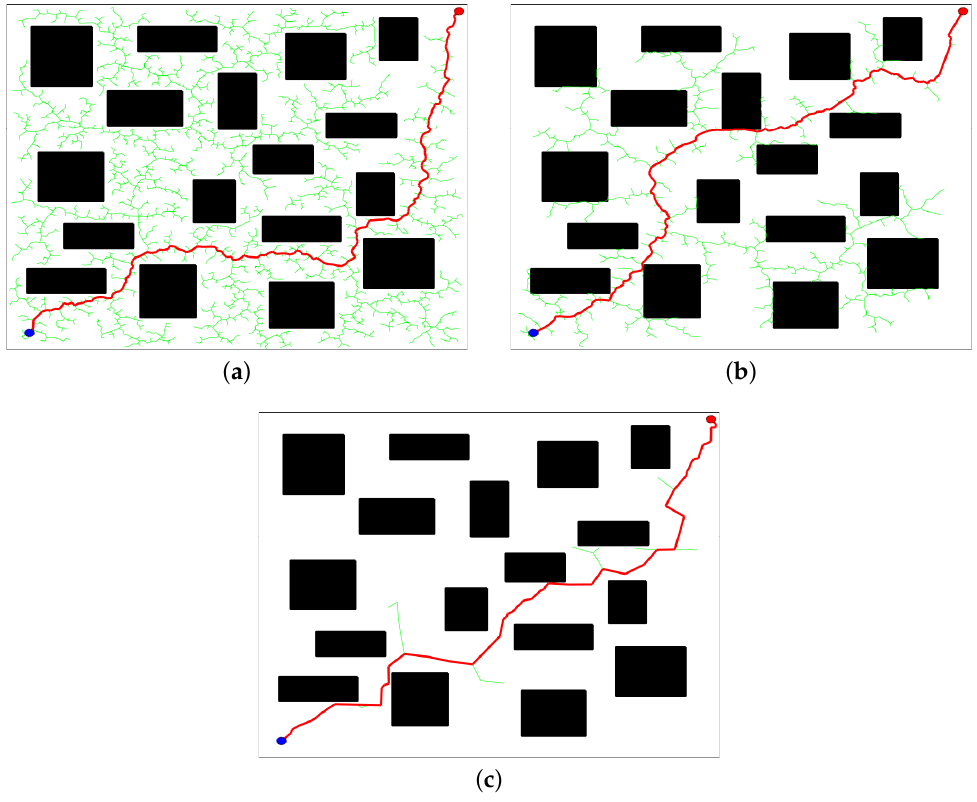
Figure 8. The performance of the three algorithms in complex environments. ( a ) RRT; ( b ) RRV; ( c ) RJ-RRT. Table 1. Results of three algorithms in complex